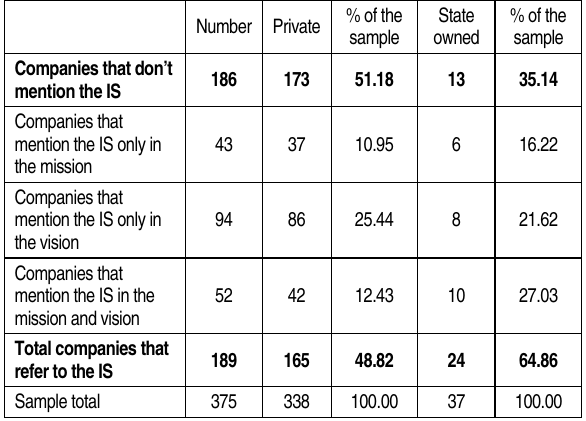
Table 5. Presence or absence of IS in the mission, vision or in both according to the type of